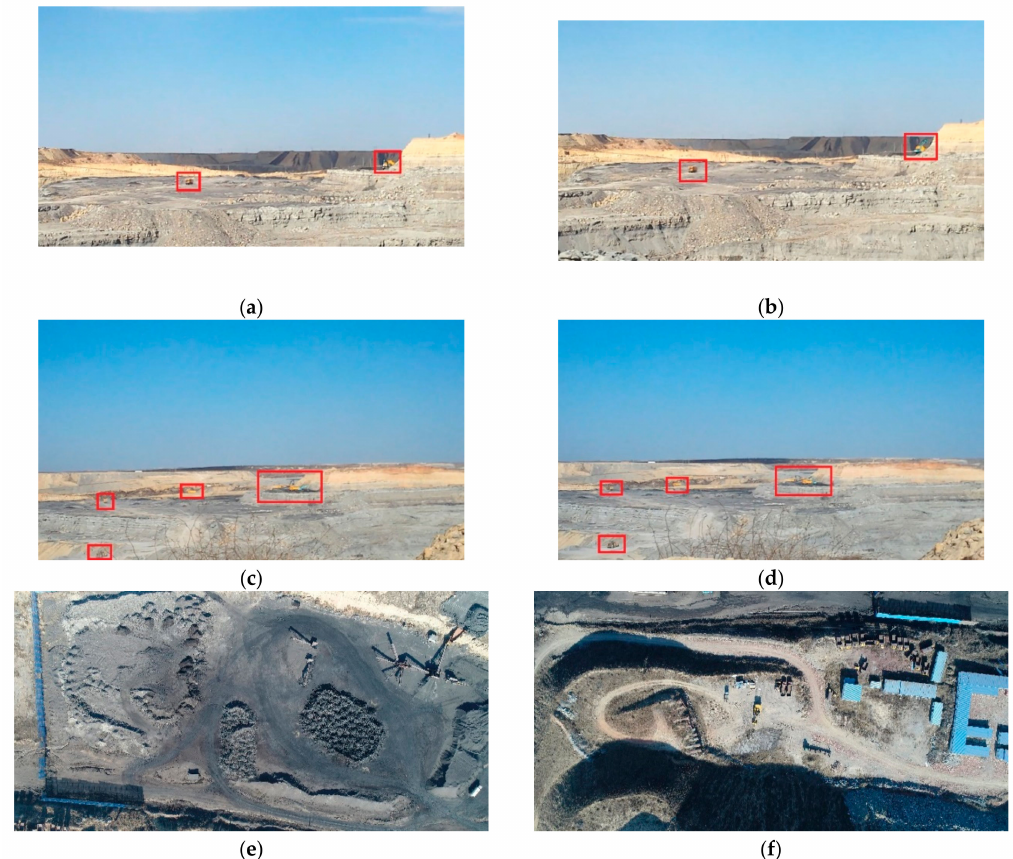
Figure 6. Field photos of possible illegal mining activity in study area B: ( a–d ) ground-based video frames of excavators and moving trucks; ( e–f ) unmanned aerial vehicle (UAV) images of coal piles and other mining